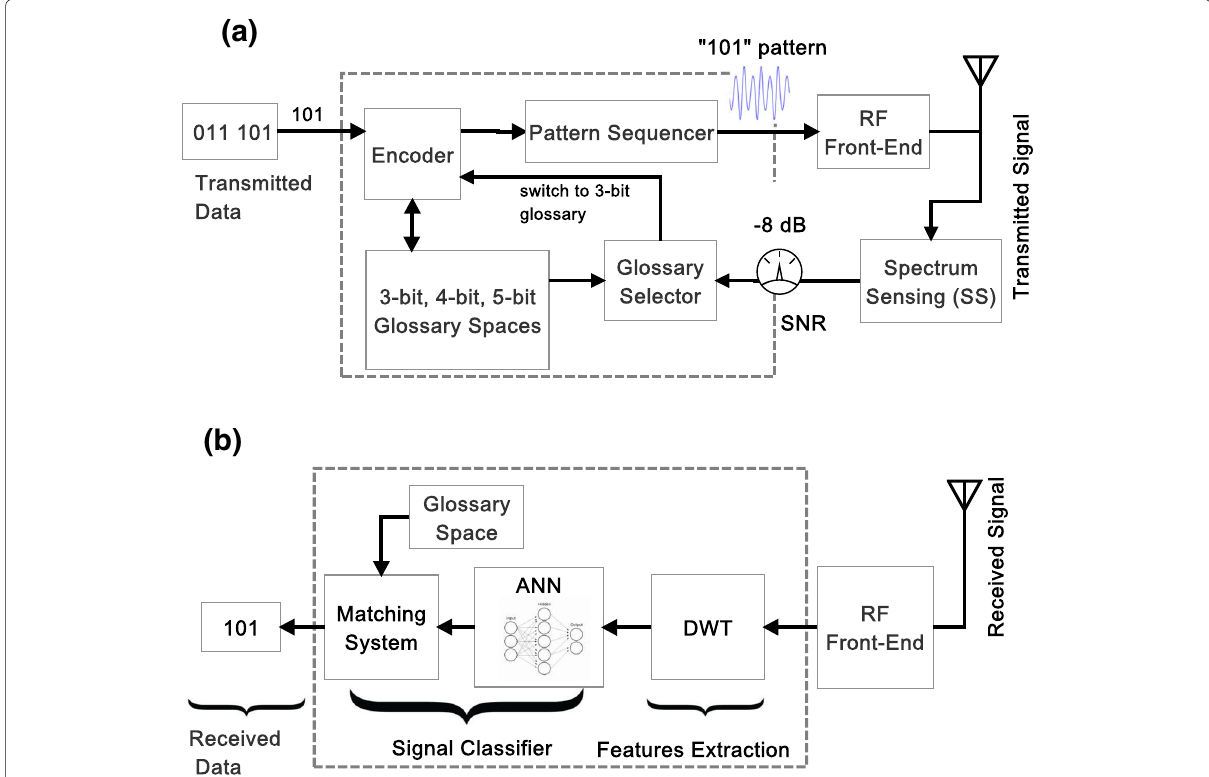
Fig. 1 The block diagram of the PBCCS. The transmitter ( a ) PBCCS Transmitter Block diagram selects a 3-bit glossary space, so the corresponding “101” waveform is transmitted. The receiver ( b ) PBCCS Receiver Block diagram receives a distorted signal and produces the corresponding